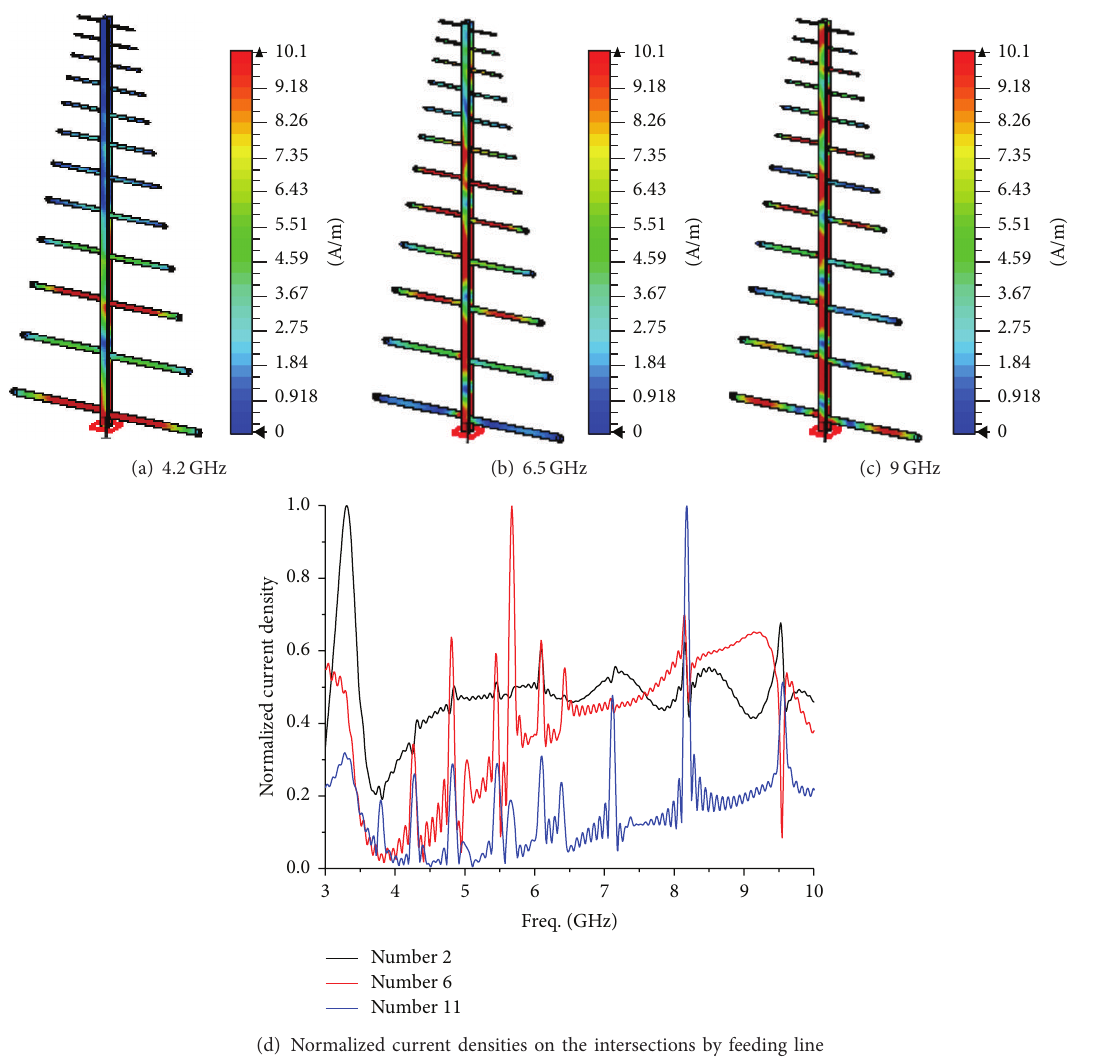
Figure 4: Currents densities of proposed